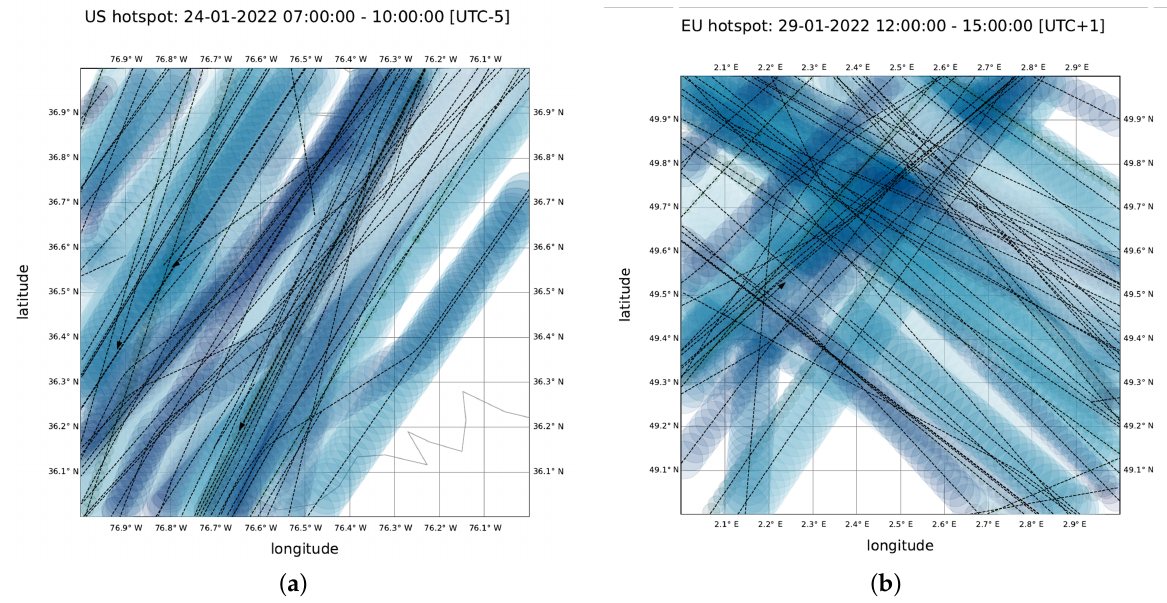
Figure 5. Plume modelling simulation for high density hot spots: ( a ) US hot spot; ( b ) EU hot